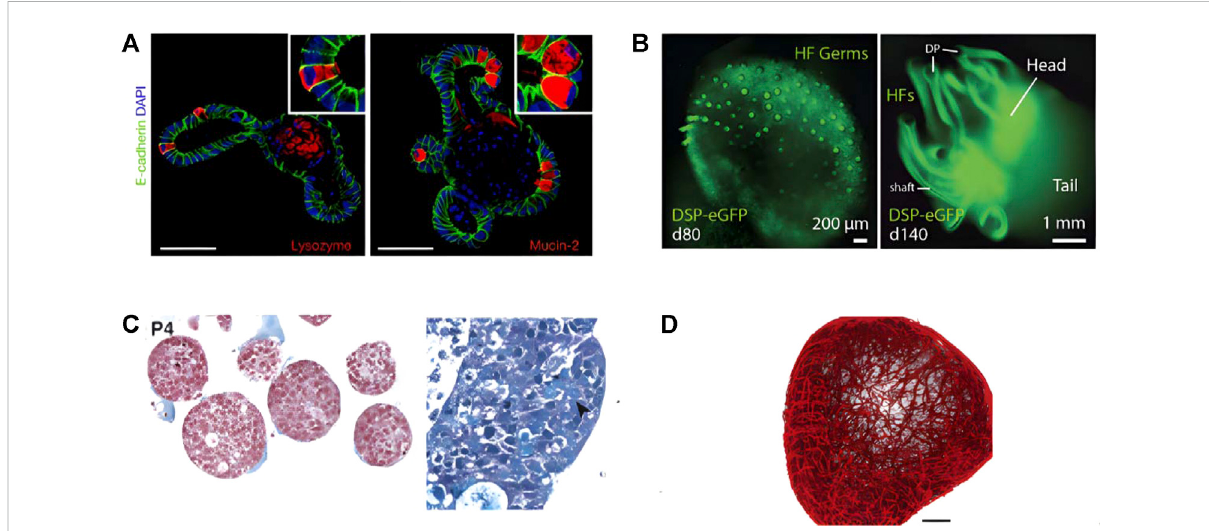
FIGURE 2 Fourdifferenttypesoforganoidsconstructedbyresearchers. (A) Intestinalorganoids(adaptedandmodi fi edfromGjorevskietal.,2016). (B) Skin organoids (adapted and modi fi ed from Lee et al., 2021). (C) Organoid Models of Human Liver Cancers (adapted and modi fi ed from Nuciforo et al., 2018). (D) Human blood vessel organoids (adapted and modi fi ed from Wimmer et al.,